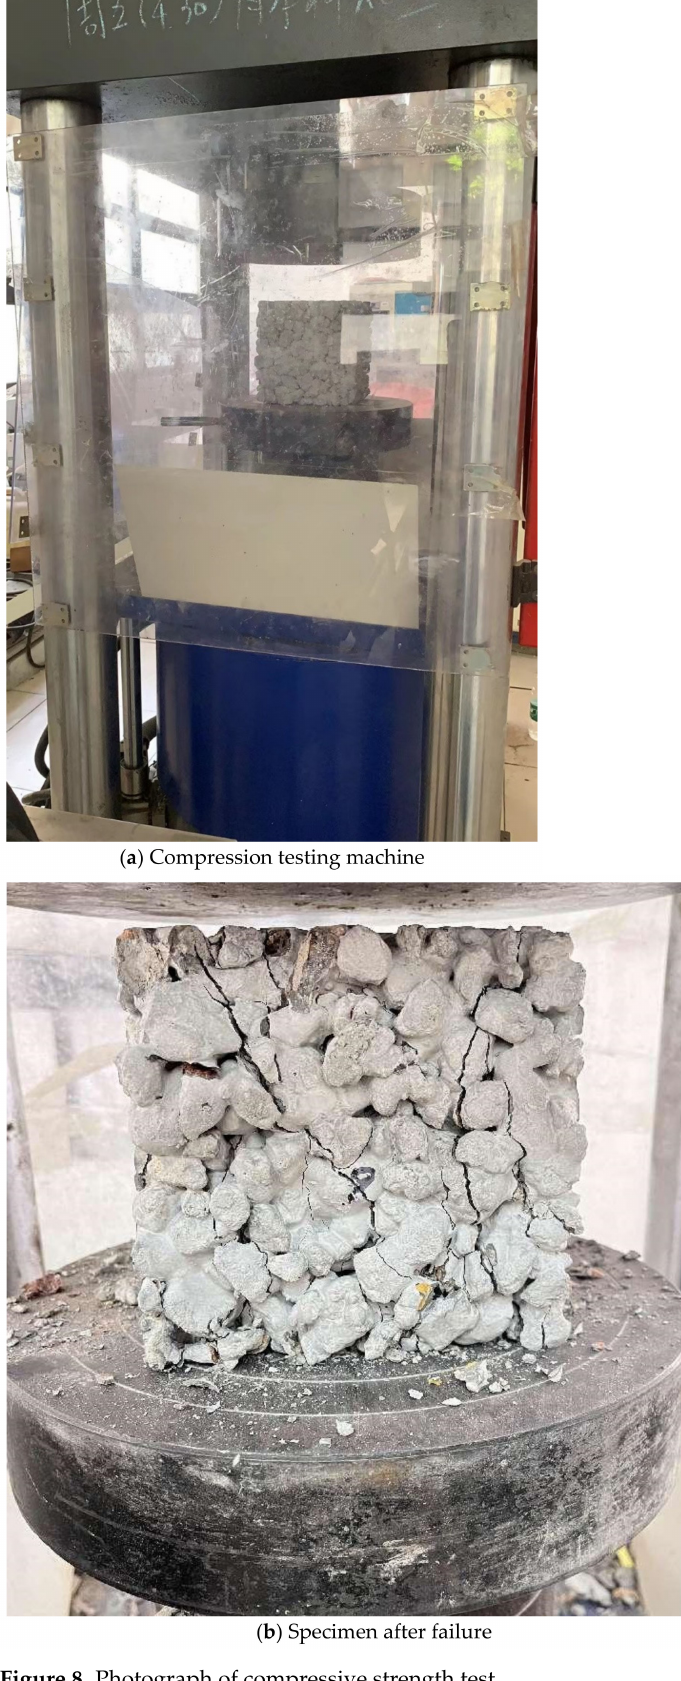
Figure 8. Photograph of compressive strength